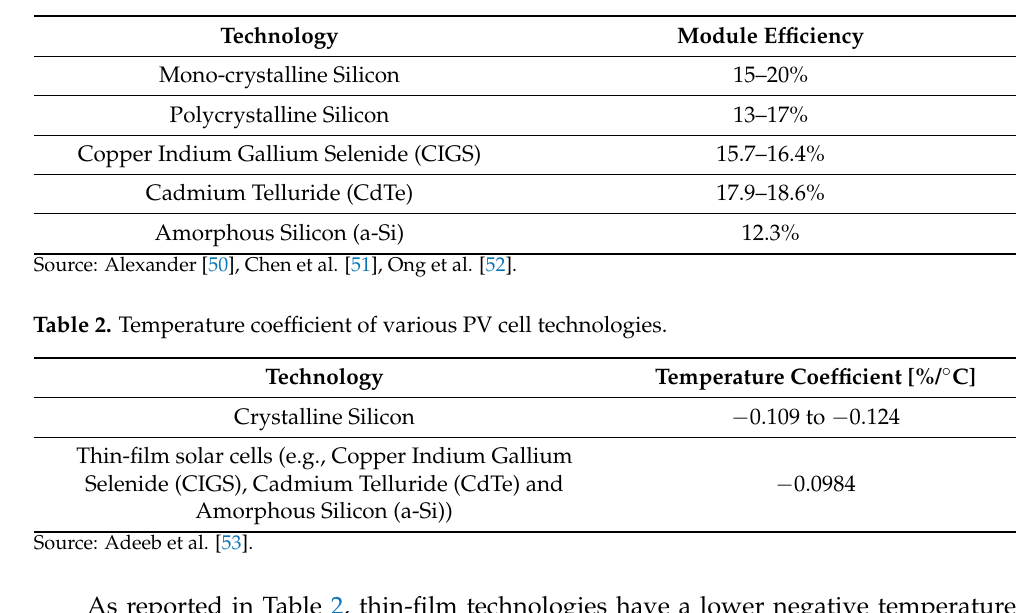
Table 1. Conversion efficiencies of various PV module technologies.